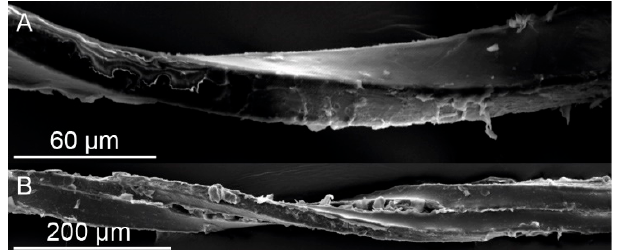
Figure 4. SEM images of a single extracted bark fiber ( A ) and two interconnected bark fibers ( B ) of the outer bark of S. giganteum showing the nearly rectangular cross-section of the fibers. An interconnection between fibers—if present—occurs exclusively between the short sides of the rectangular cross-section (cf. Figure 3). The twisting of the fibers is due to dehydration of the samples before and during SEM